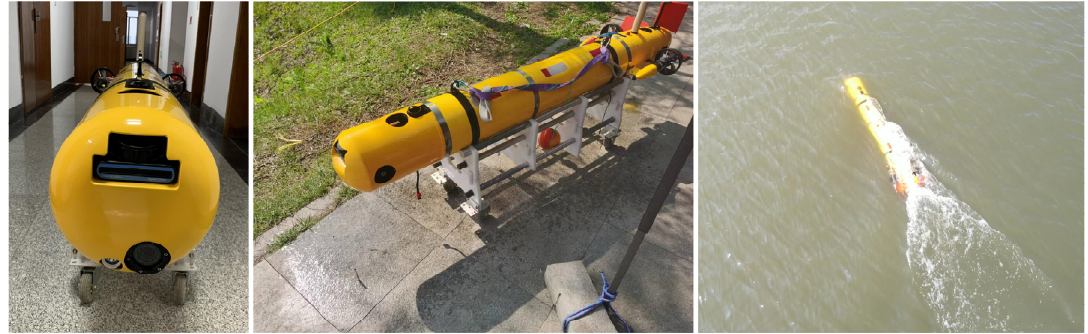
Figure 4. AUV-R physical picture and experimental picture.